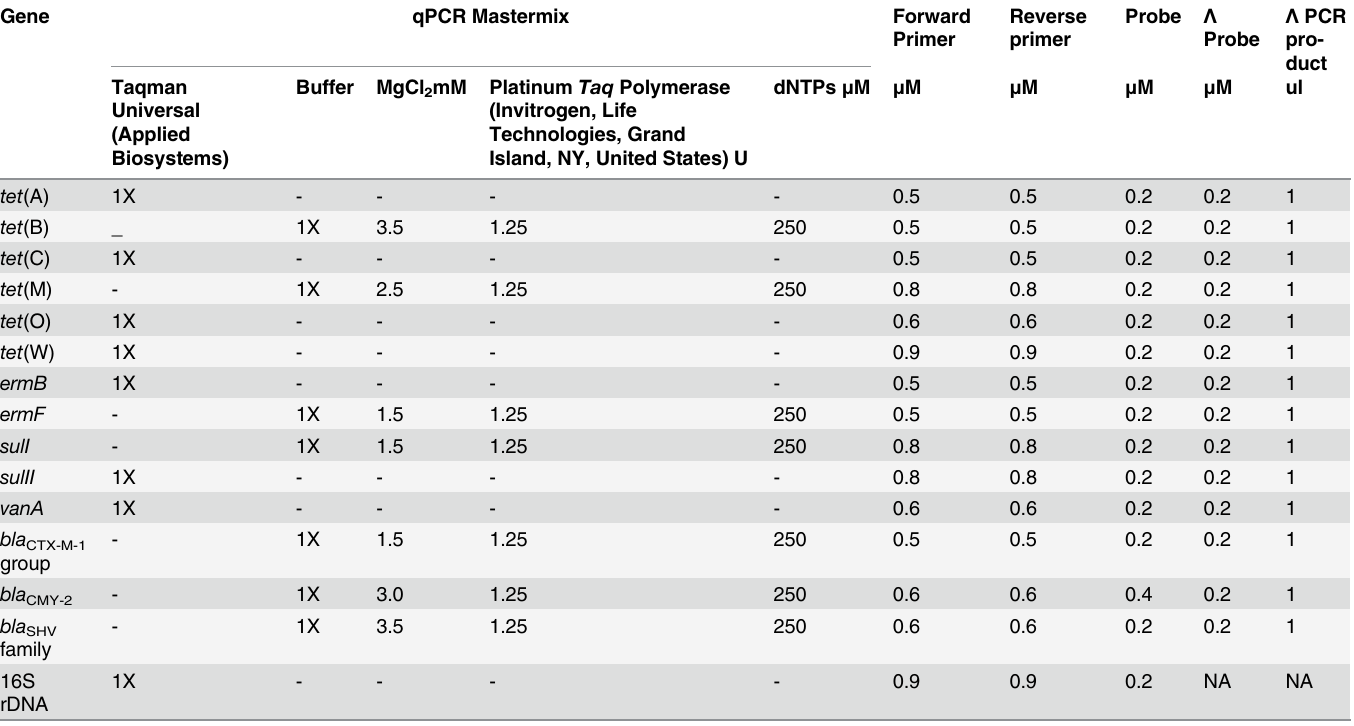
Table 3. Concentrations of reagents per reaction used in qPCR assays with a total reaction volume of 25 μ l including 2 μ l DNA.